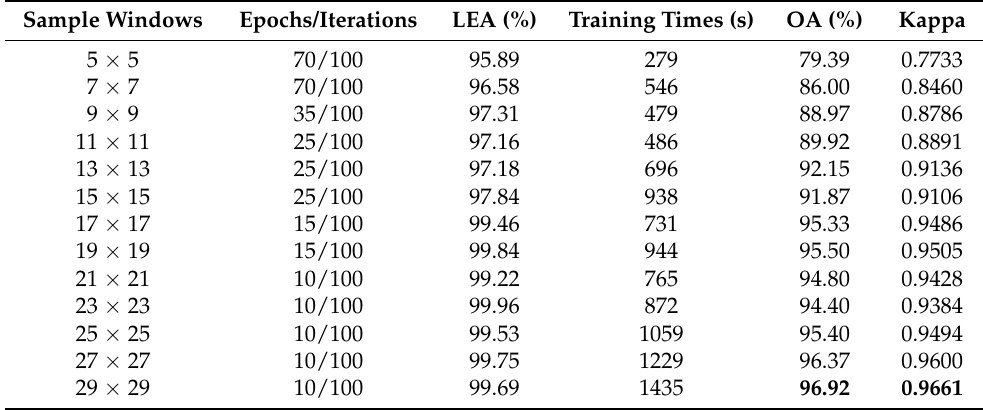
Table 4. Classification accuracy using the prototypical networks in different